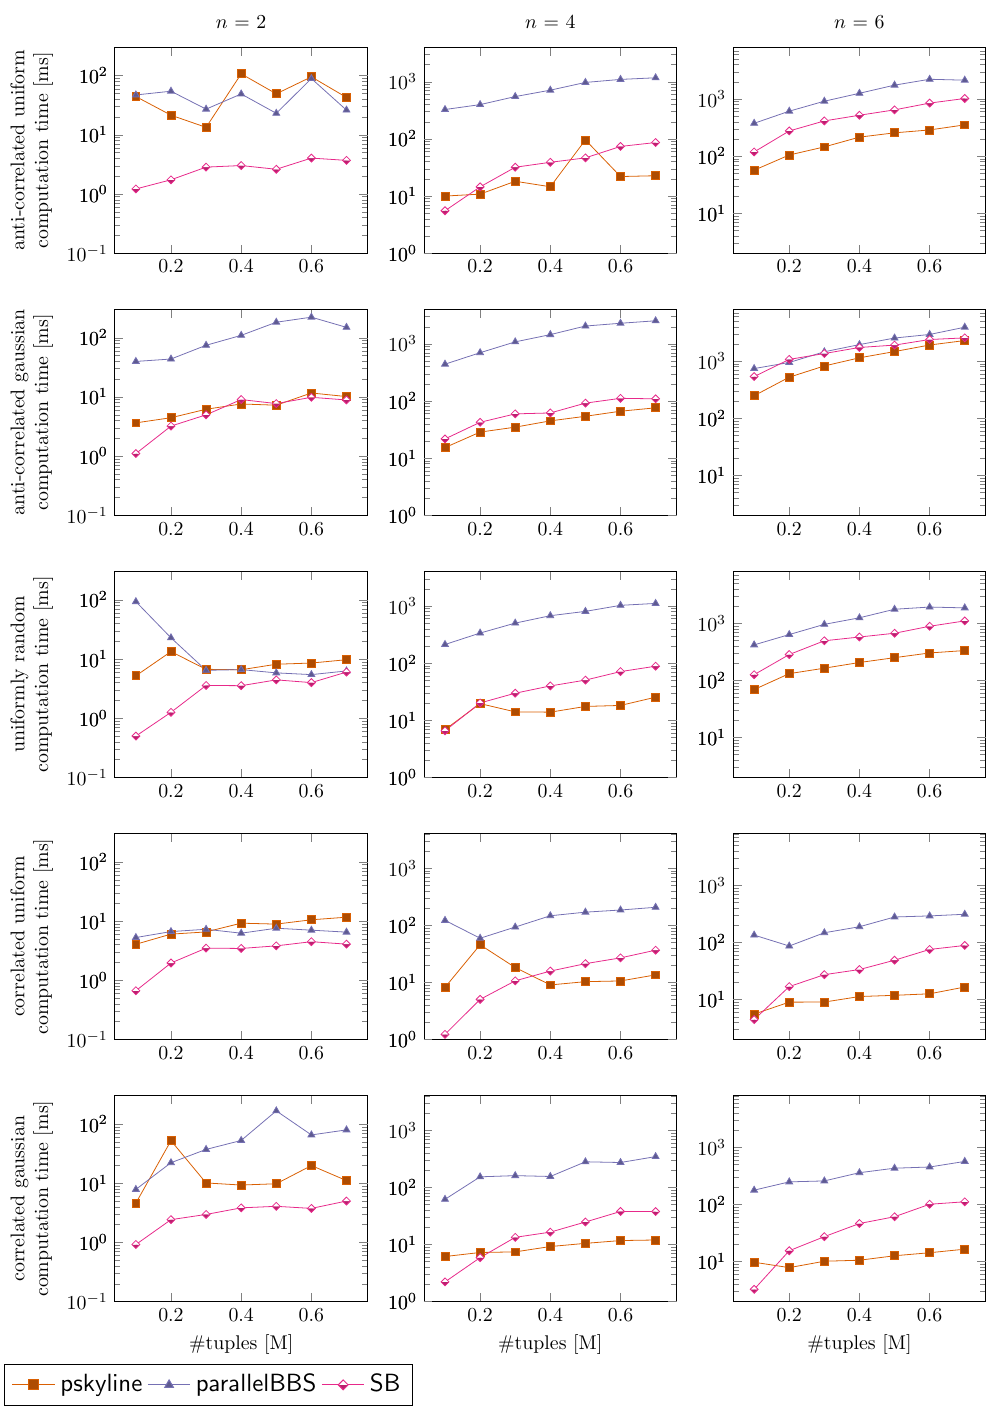
Figure 6. Experiment varying the size of the input (in millions [M], i.e., 10 6 ) with four threads. The time ( y -axis) is in milliseconds and logarithmic scale. Each row uses a different random distribution of the input values, and each column corresponds to a specific dimension n of the feature vectors. The number of input tuples varies from 100,000 to 700,000 with steps of 100,000